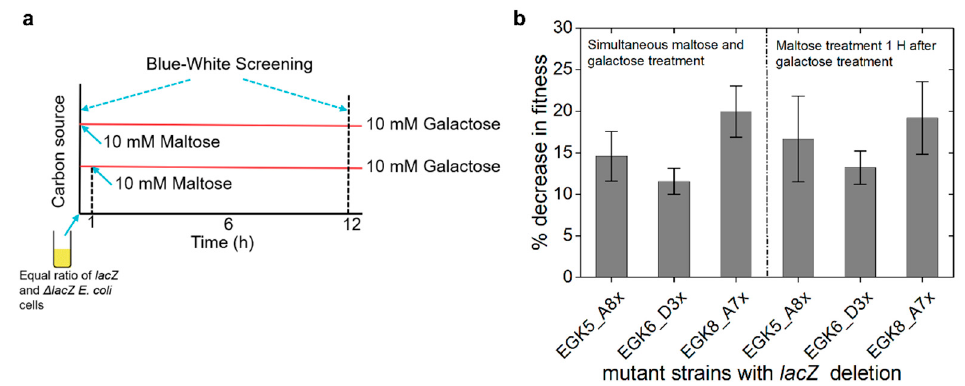
Figure 5. Competition assays to measure the fitness of lacZ deleted mutant strains showing a positive association between D-galactose treatment and malP expression. ( a ) Experimental strategy; ( b ) Fitness of lacZ deleted mutant strains against wild type strain MING.